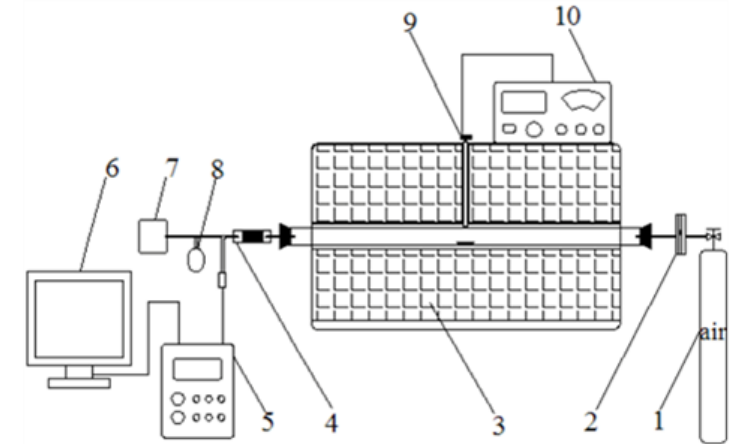
Figure 1. The diagram of experimental apparatus: 1. gas bottle; 2. flowmeter; 3. tubular furnace; 4. filter; 5. flue gas tester; 6. computer; 7. effluent gas treatment system; 8. gas collecting bag; 9. thermocouple; 10. temperature controller.